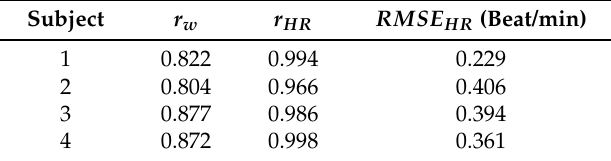
Table 2. Signal indexes for comparison between the active electrode and the Ag/AgCl electrode.